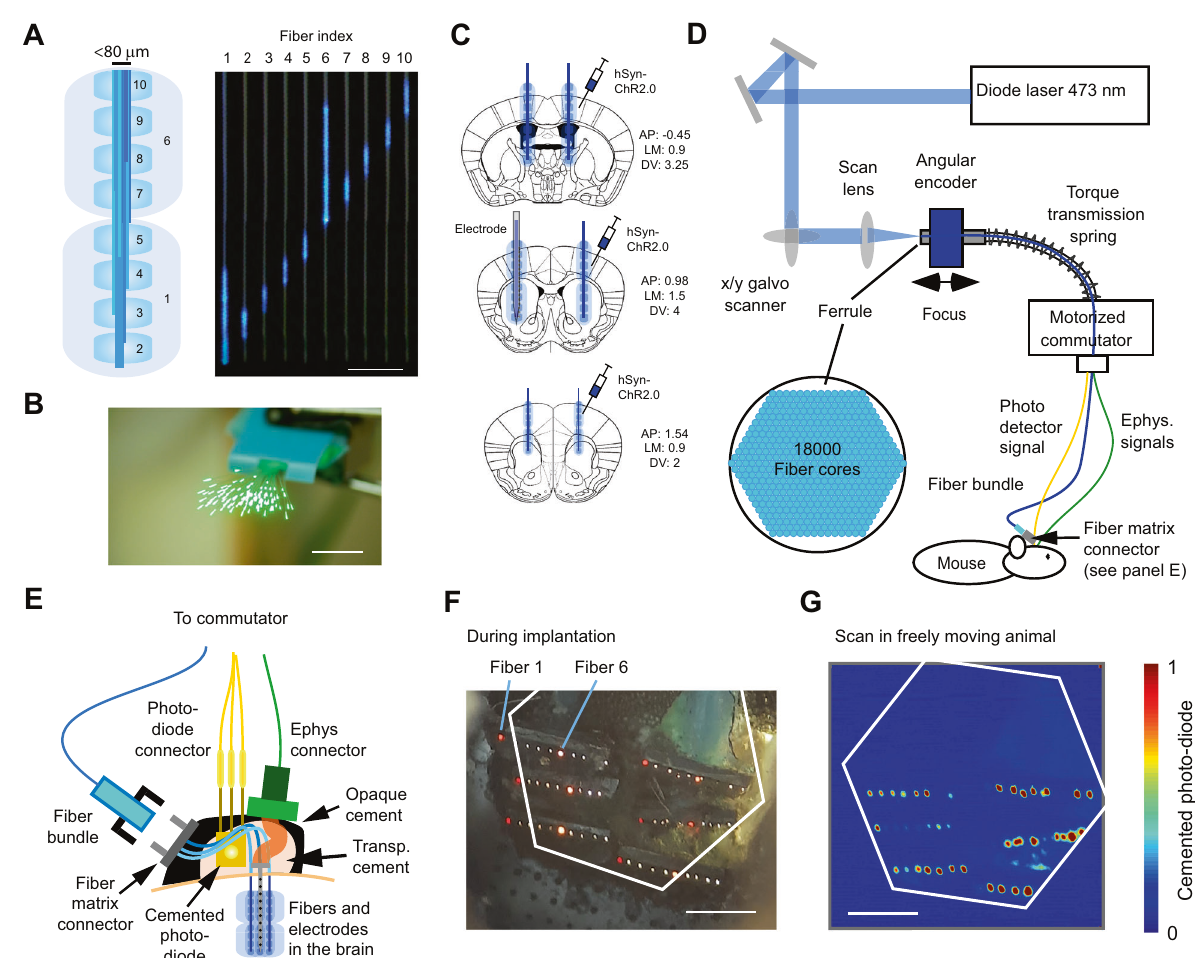
Fig. 3 System for three-dimensional optogenetic stimulation and laminar recordings in freely moving mice. A Fiber-bundle probe used in the experiments for light emission at different depths in the brain tissue. Scale bar: 1 mm. Schematic side view (left panel); sequentially illuminated fi bers lead to de fi ned depth illumination (right panel). B Multi fi ber polishing holder and ~70 simultaneously polished fi bers illuminated with green light